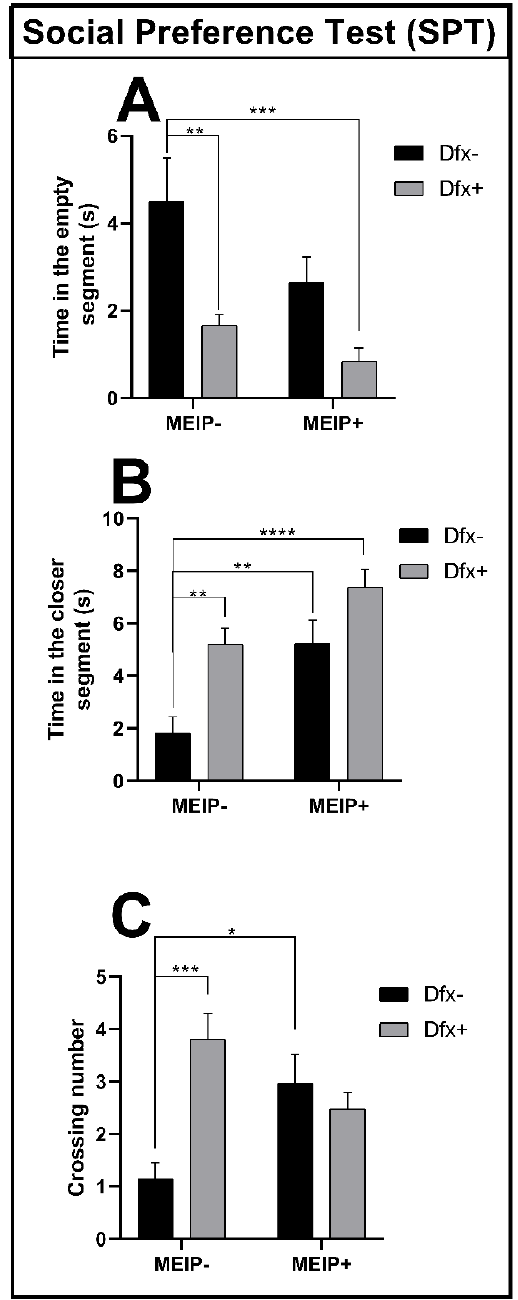
Figure 3. Social Preference Test (SPT) in Zebrafish. Representation of the time in the empty segment ( A ); time in the closer segment ( B ); and number of line crossings ( C ) of fish exposed to Dfx supple- mented MEIP. Data are expressed by the mean ± SEM analyzed by ANOVA two-way with Tukey’s post-hoc test. * p < 0.05, ** p < 0.01, *** p < 0.001, and **** p < 0.0001.